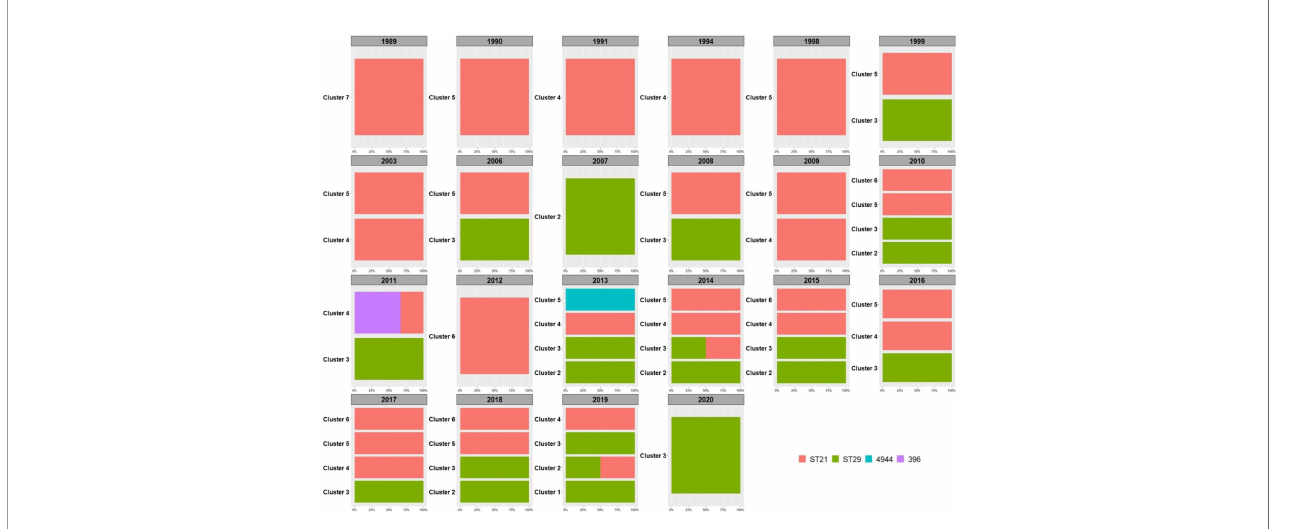
FIGURE 3 | Distribution of HCPC clusters in time. The percentage of the detected Sequence Types is reported within each year and per cluster. The legend for the colors indicating the STs is included in the fi